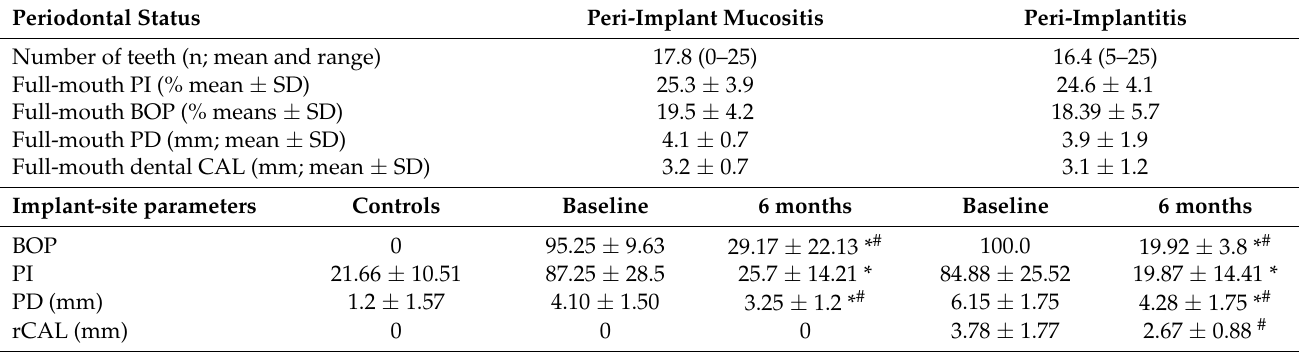
Table 1. Clinical characteristics of the study